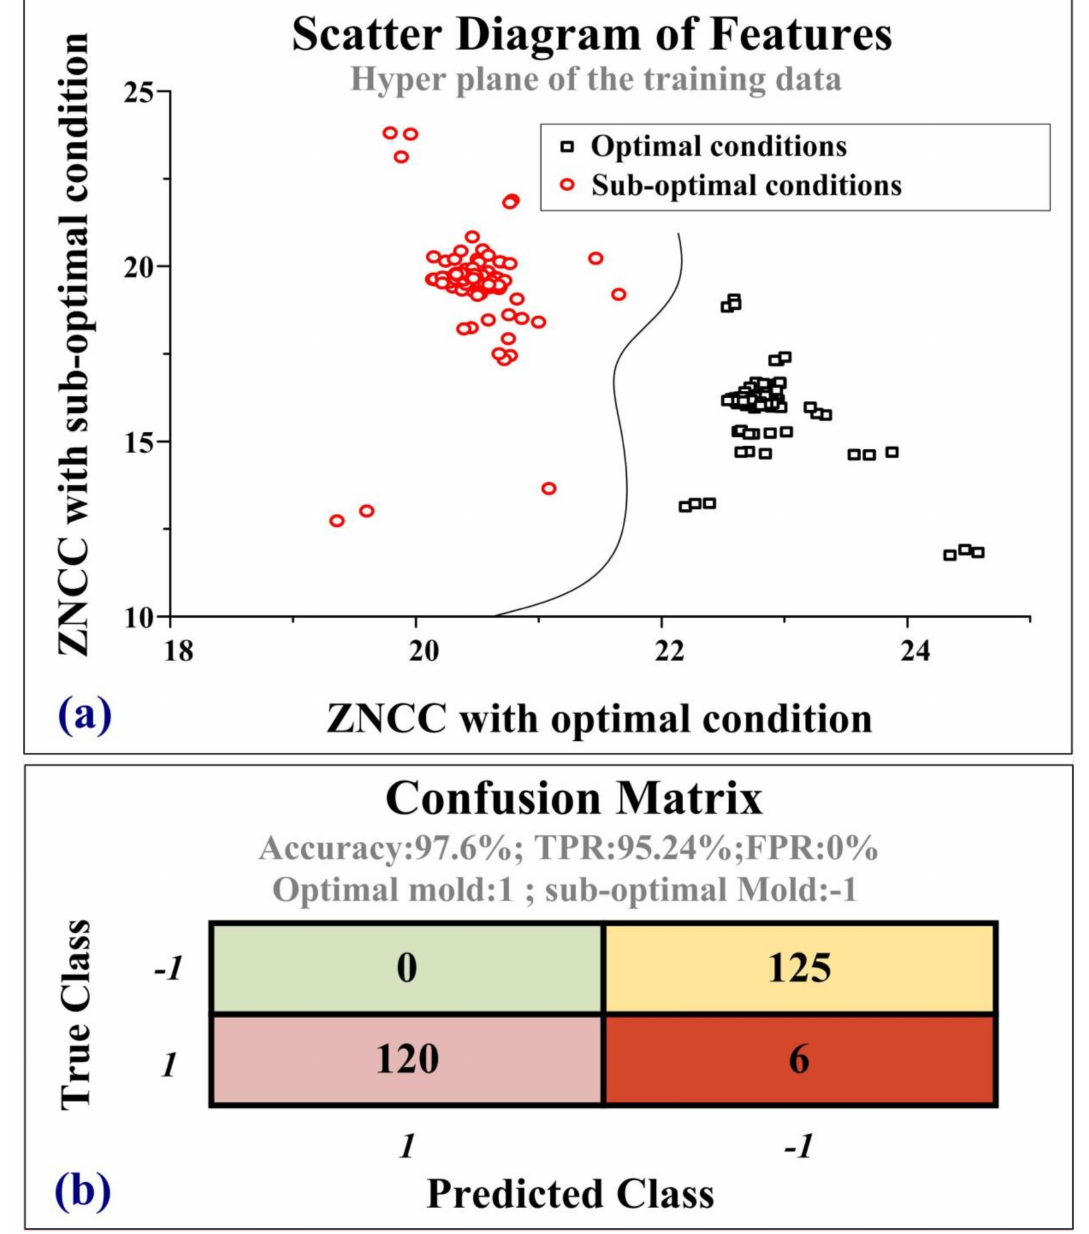
Figure 10. SVM program for the identification of sharp and blunt edges: ( a ) scatter plot of features in training data and ( b ) confusion matrix of measured signal; fault classification based on zero mean cross-correlation to ensure high accuracy for industrial